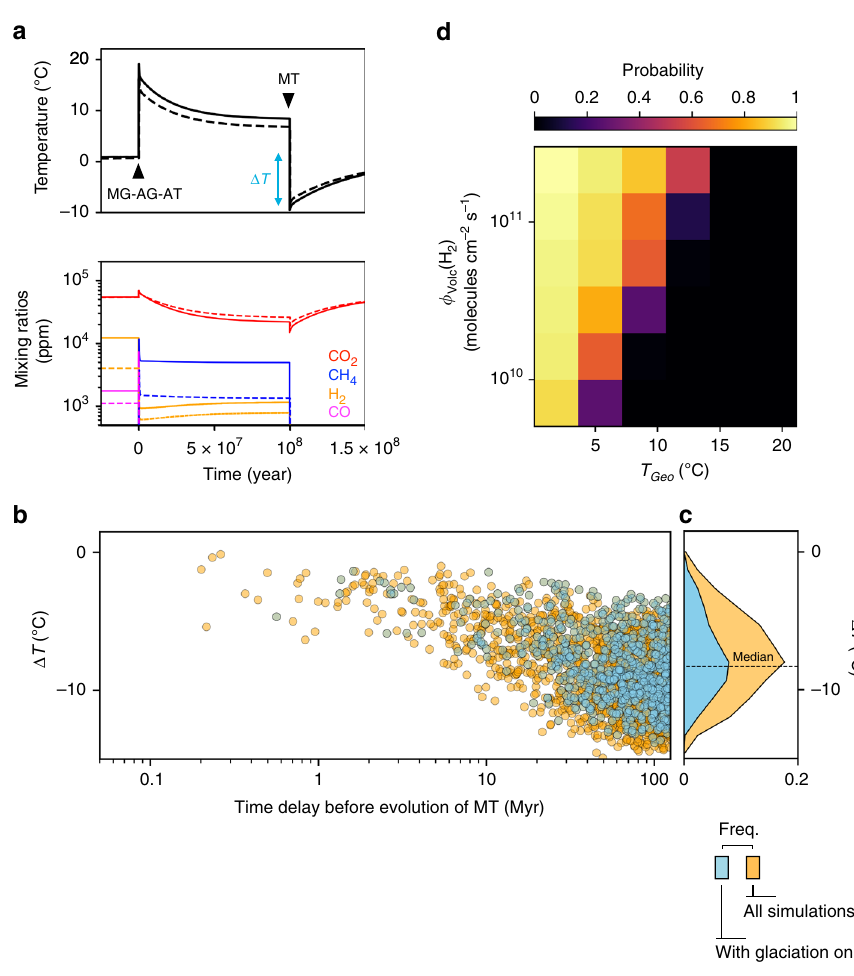
Fig. 5 Climate destabilization by evolutionary metabolic innovation. a In this example, sulfur-based methanotrophy (MT) evolves 100 million years after MG + AG + AT, i.e. after equilibration of the methanogenic biosphere (MG + AG + AT) with the atmosphere and climate mediated by the carbon cycle, with T Geo = 2 °C, φ volc (H 2 ) = 3 × 10 11 (plain lines) and 1 × 10 11 molecules s − 1 cm − 2 (dotted lines). Top, change in surface temperature. Bottom, change in atmospheric composition. b , d Distribution of outcomes across a range of abiotic temperature T Geo , H 2 volcanic fl ux, and evolution time of MT (2000 randomly chosen combinations). b Amplitude of global cooling, Δ T , with respect to the evolution time of MT. c Frequency distribution of all temperature changes Δ T (blue) and of temperature changes conditional on glaciation outcome (yellow). d Estimated probability of glaciation as a consequence of MT evolution, given the abiotic temperature T Geo and H 2 volcanic fl ux. Other parameters are set to their default values (Supplementary Tables 2 and